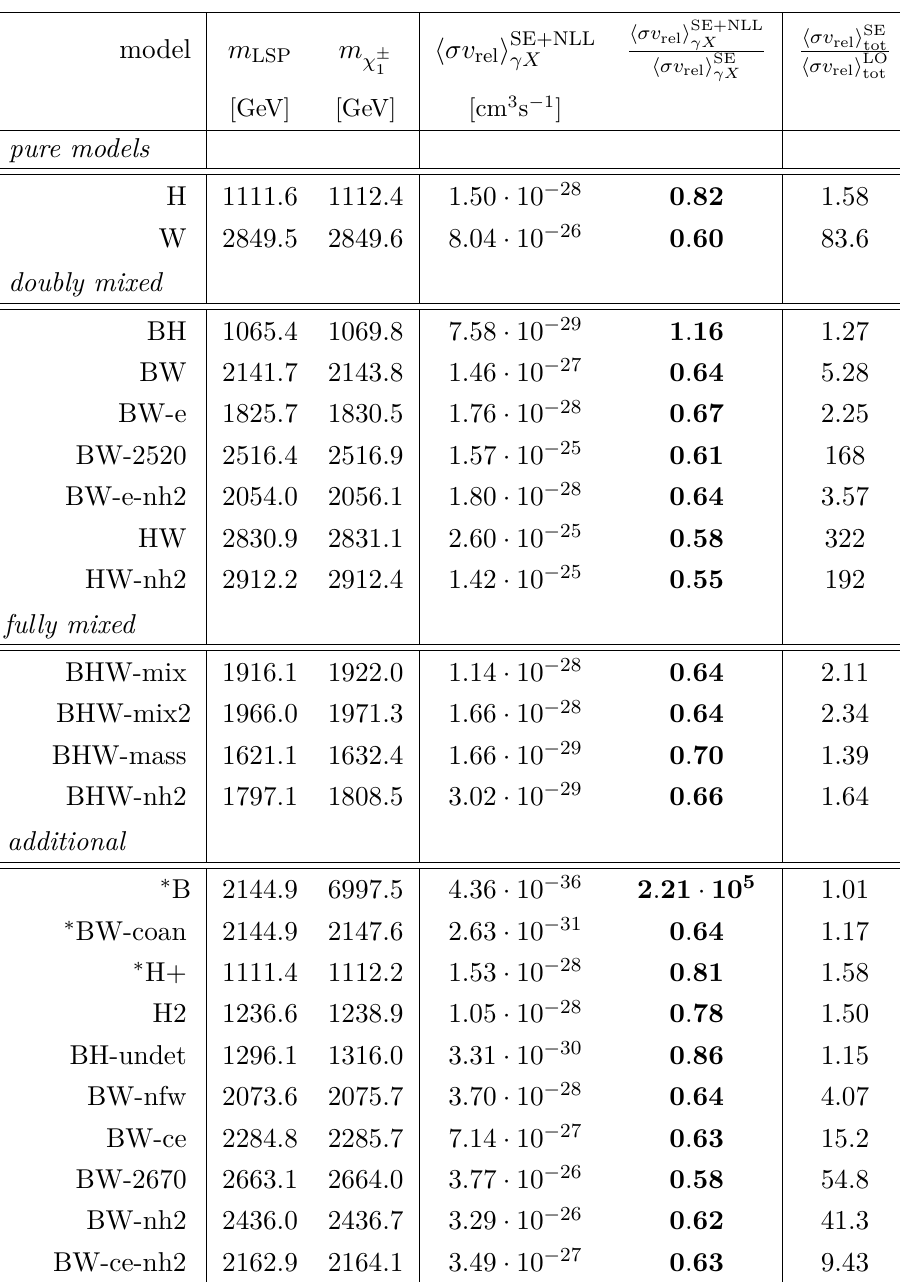
Table 1 . Summary of results for the 23 selected MSSM benchmark models. See explanation in the main